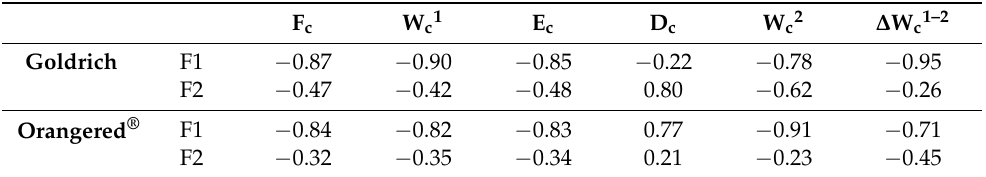
Table 2. Correlation coefficients ( p ≤ 0.05) between the first two discriminant scores (F1 and F2) and texture parameters extracted from the force/deformation curves. F c W c1 E c D c W c2 ∆ W c1–2 F1 − 0.87 − 0.90 − 0.22